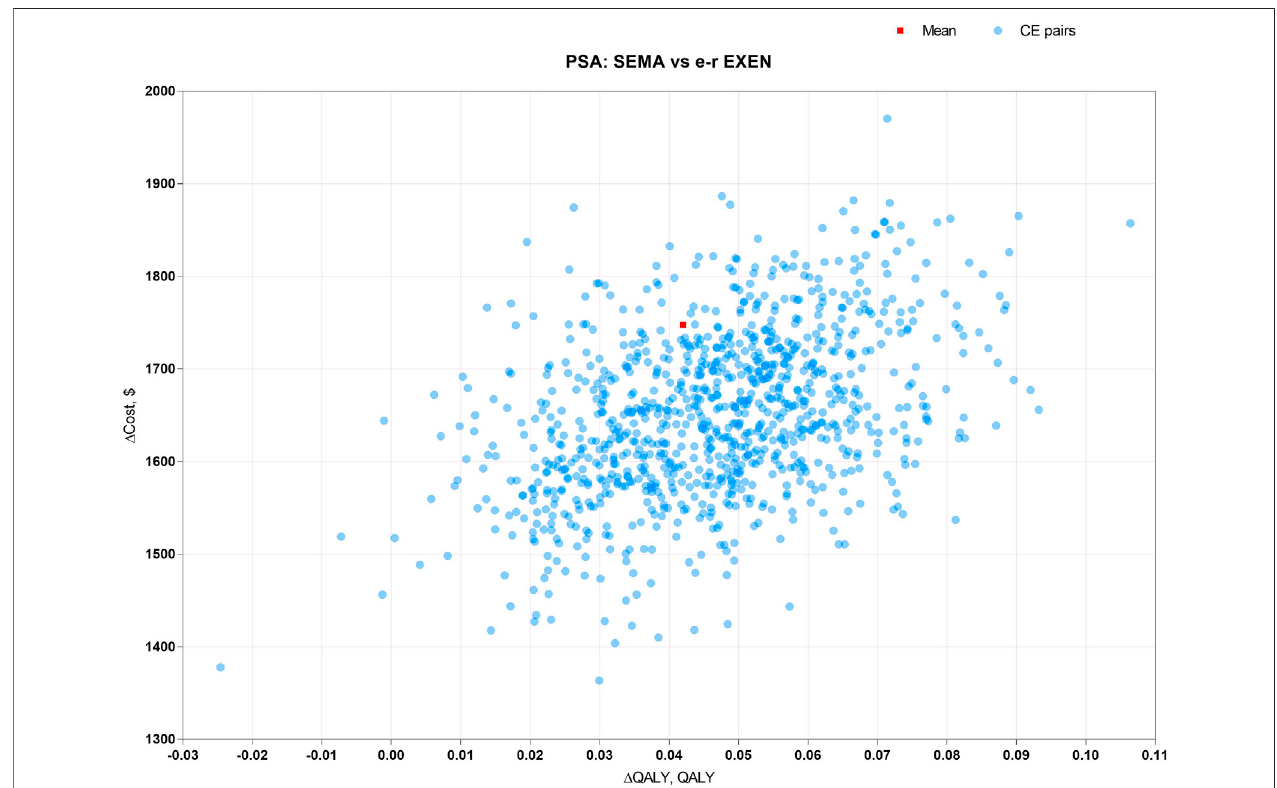
FIGURE 4 | Scatter plots of ICUR for sc. SEMA vs. e-r